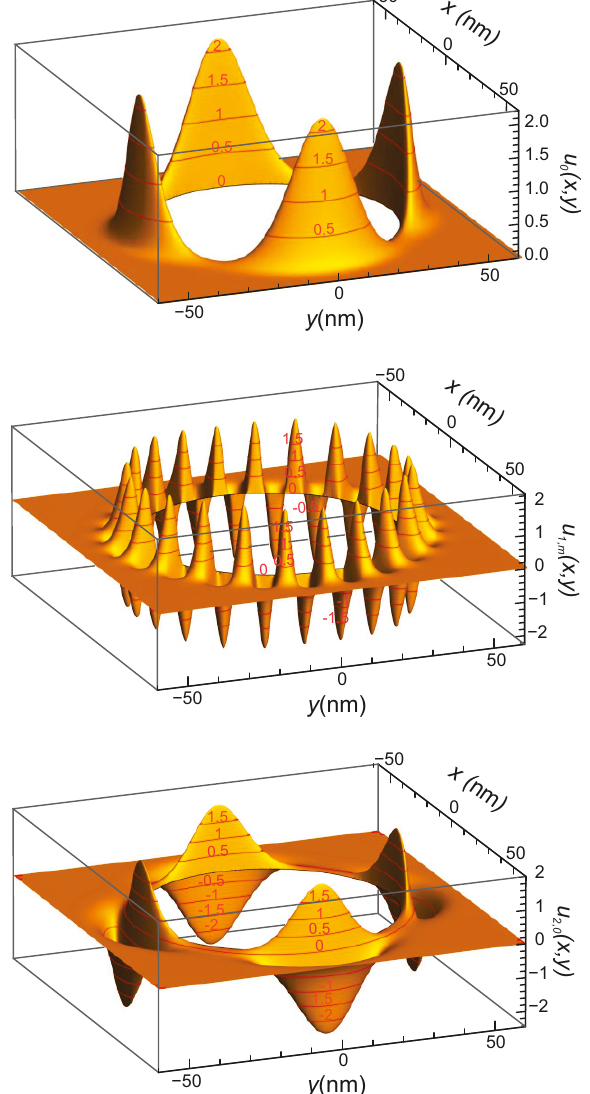
Figure 5. Views of three wave functions in the case of array model 2 ( R = 40 nm and a = 200 nm). Top : ground-state, no node; middle : highly excited state of the first shell of states, 22 circumferential nodes; bottom : first state in the second shell of states ( n = 2), a radial node. In red, curves of wave-function equal values, indicated on the curves. See text for more detail, including definition of wave-function